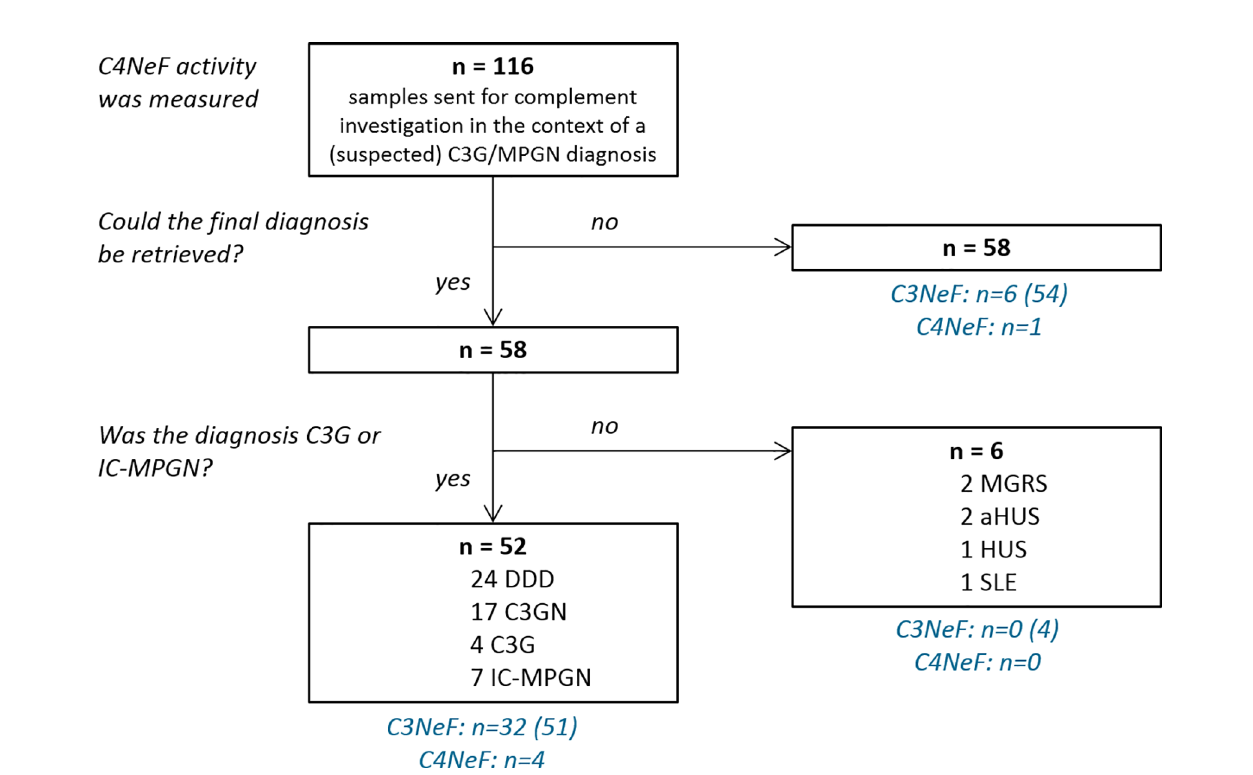
FIGURE 1 | Flow chart of sample inclusion. All patient samples were measured for prolonged classical pathway activity, i.e. C4 nephritic factor (C4NeF) activity, but only the 52 patients with a fi nal diagnosis of C3 glomerulopathy (C3G) or immune complex-mediated membranoproliferative glomerulonephritis (IC-MPGN) were included in this study. C3 nephritic factor (C3NeF) activity, i.e. prolonged alternative pathway activity, was measured in the number of patients indicated between brackets. DDD, dense deposit disease; C3GN, C3 glomerulonephritis; MGRS, monoclonal gammopathy of renal signi fi cance; HUS, hemolytic uremic syndrome; aHUS, atypical HUS; SLE, systemic lupus